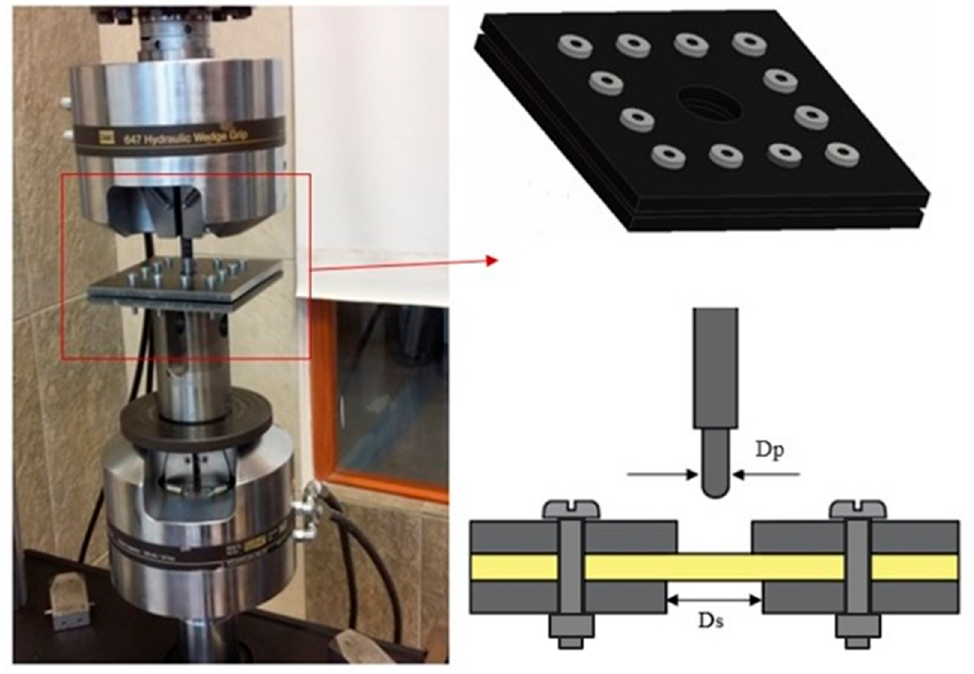
Figure 4. Schematic of a quasi-static punch shear test fixture.